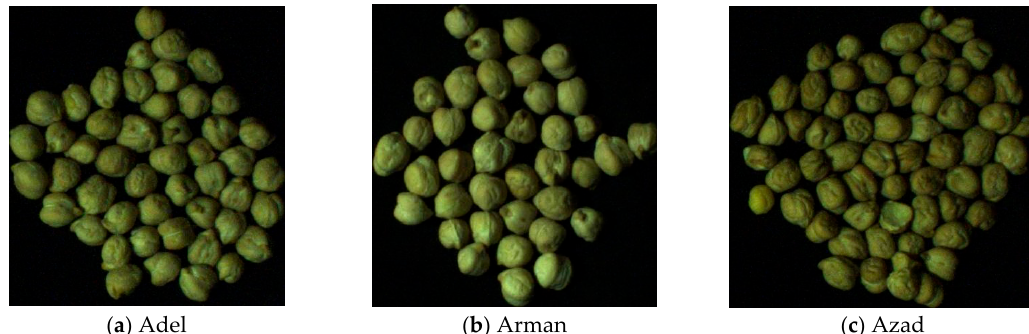
Figure 2. A sample image of each of the three chickpea ( Cicer arietinum L.) varieties under consideration: ( a ) Adel, ( b ) Arman, and ( c ) Azad.